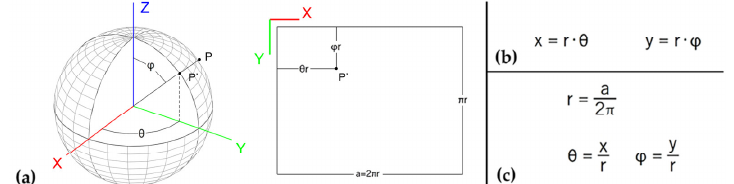
Figure 1. Relations between spherical coordinates and coordinates on spherical photographs, where O is the origin of the polar system, P is a point in the 3D space, P′ is the point projection on the sphere, θ is the horizontal angle, φ is the vertical angle, and r is the radius of the sphere. ( a ) Graphical representation of the relations between polar coordinates measured by the terrestrial laser scanner and coordinates on the raster image in spherical projection [38], ( b ) formula which allows for recalculation of polar coordinates onto raster coordinates in spherical projection, and ( c ) formula that allows for recalculation of x,y raster coordinates in spherical projection onto polar